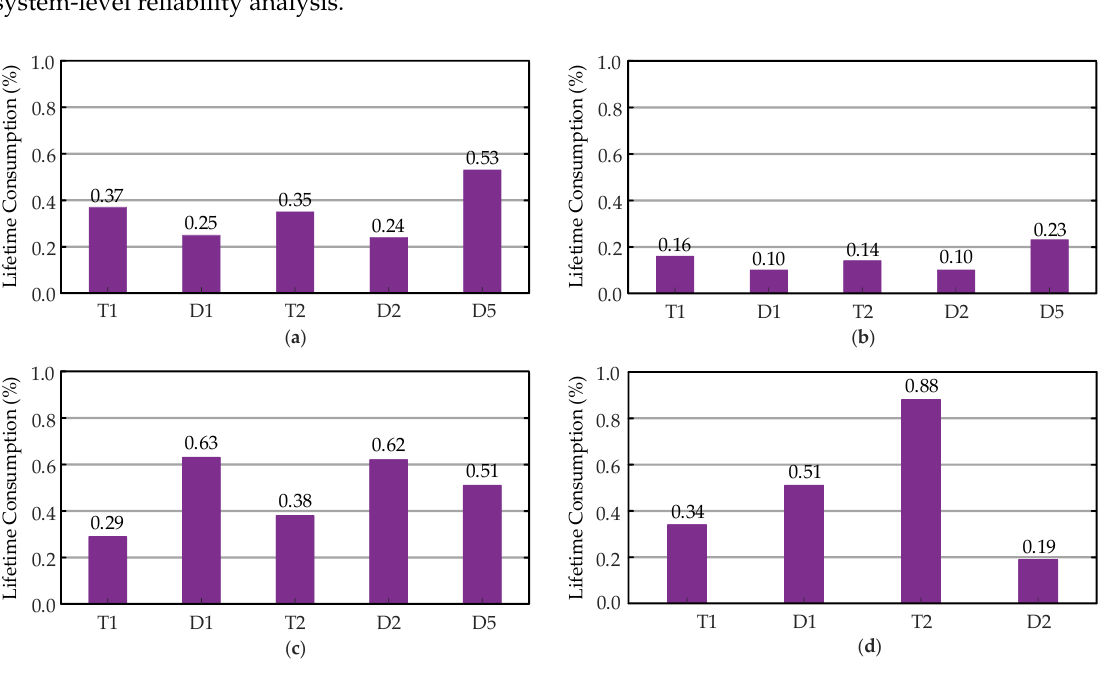
Figure 10. One-year LC results of the power devices in different power converters: ( a ) PV inverter in the AC-coupled configuration, ( b ) PV inverter in the DC-coupled configuration, ( c ) battery inverter in the AC-coupled configuration, and ( d ) battery converter in the DC-coupled